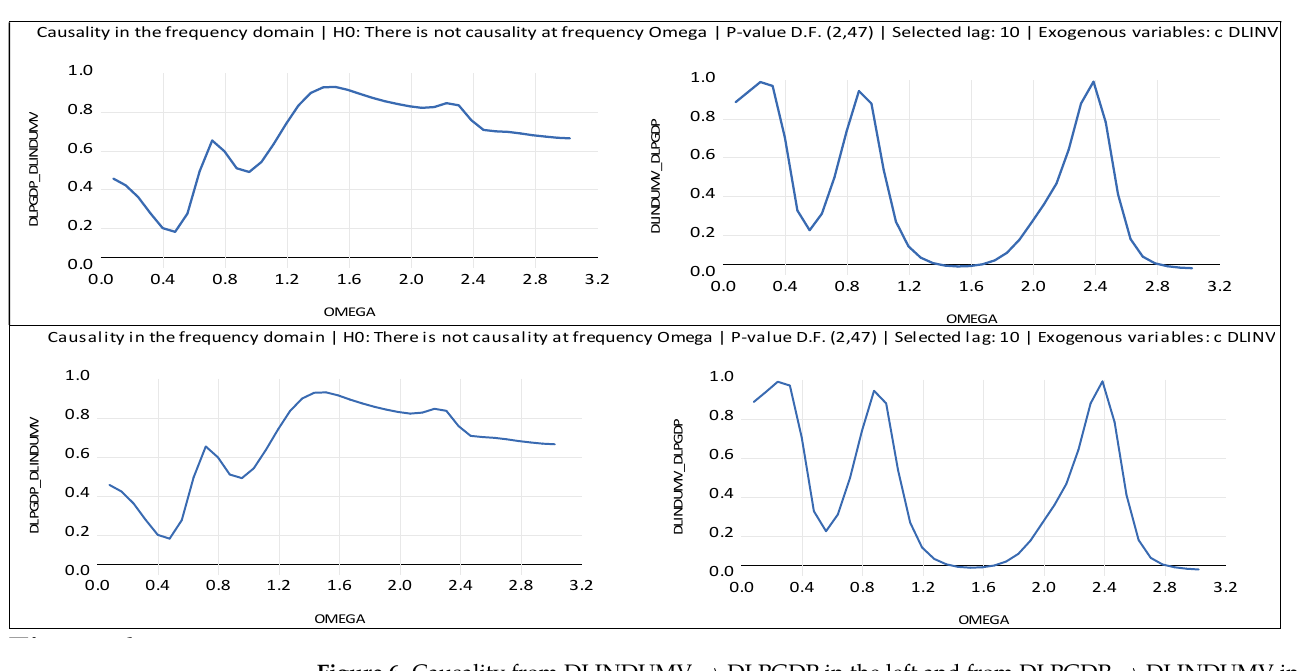
Figure 5: Causality from DLINDUHV → DLPGDP in the left and from DLPGDP → DLINDUHV in the right.